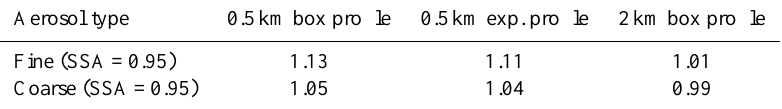
Table 6. Wintertime aerosol correction factors, defined as the ratio of the AMF with and without aerosols, calculated with the SCIATRAN radiative transfer model for typical wintertime scenarios over the eastern United States. The AOT was 0.15 (at 470nm), and the solar zenith angle 50 ◦ . The vertical profiles refer to a constant extinction from the surface up to 0.5km, and to extinction values that decrease exponentially with altitude. The assumed NO 2 profiles refer to the TM4 average shown in Fig. 13 (upper panel) for situations when MODIS AOT >